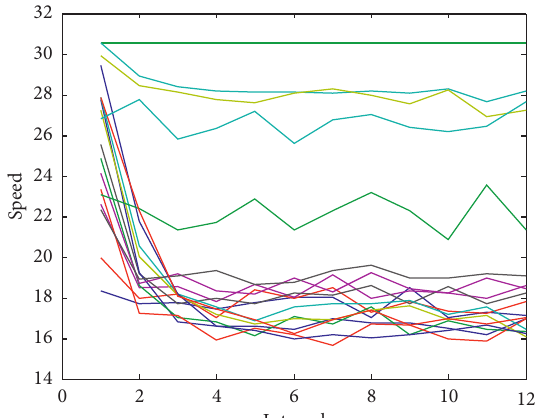
Figure 12: Two-dimensional speed without VSL.